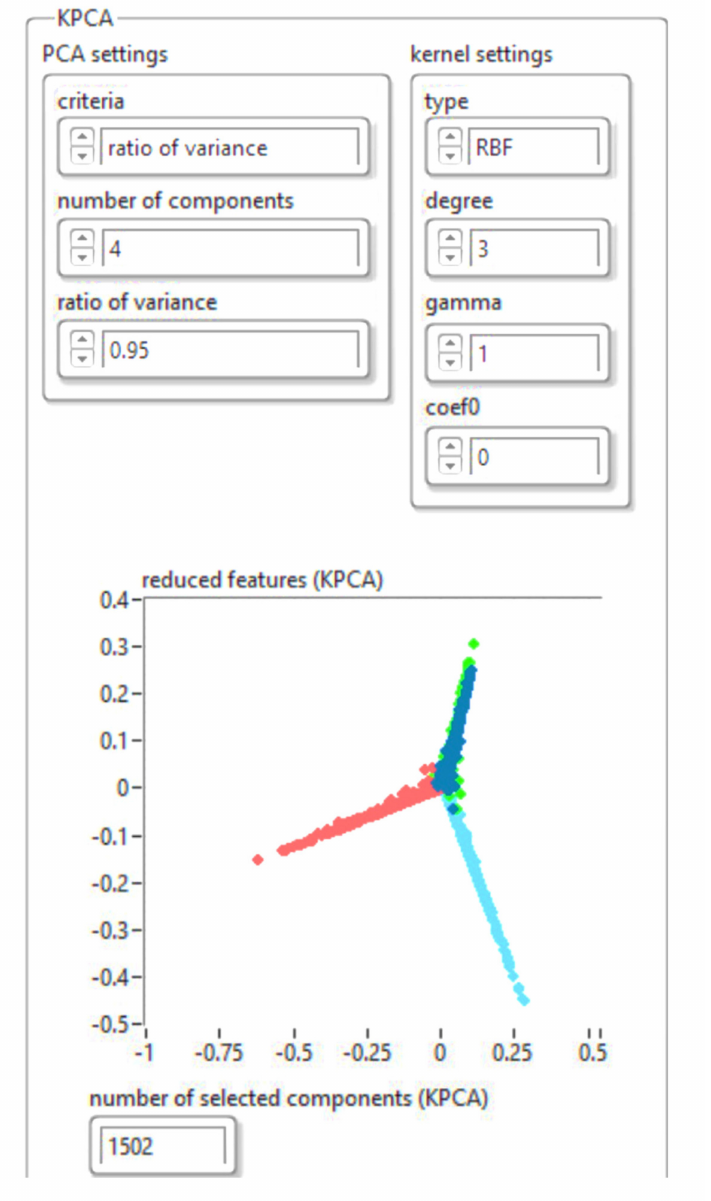
Figure 11. Implementation of the KPCA algorithm for feature manipulation. The results obtained for reducing the database size using the KPCA algorithm are shown in Figure 12. The drive file was saved in “json”